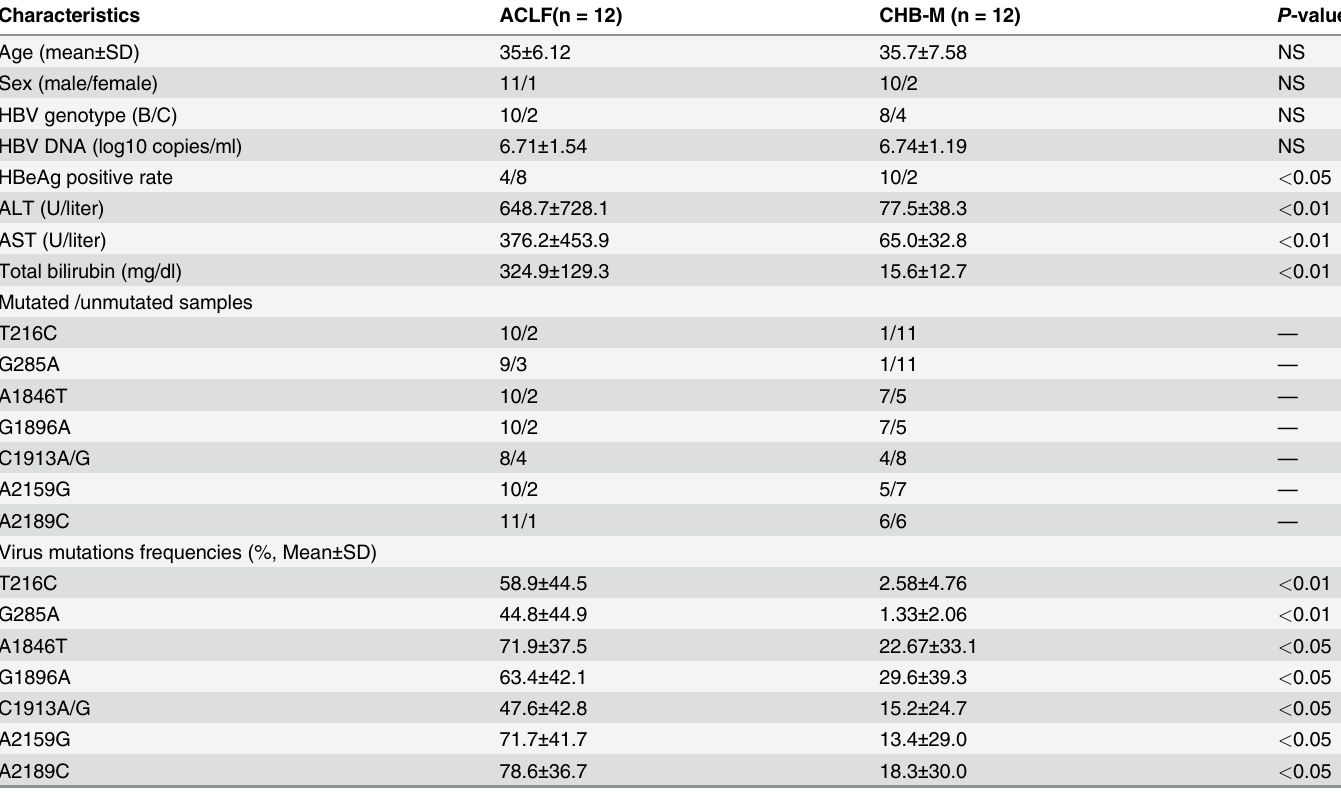
Table 2. Clinical characteristics and HBV mutation features of the patients involved in Illumina sequencing.